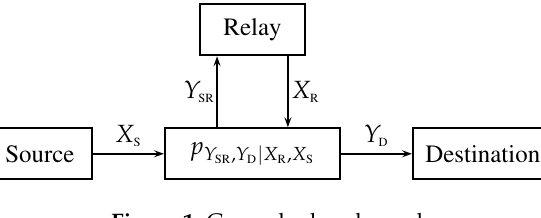
Figure 1. General relay channel.